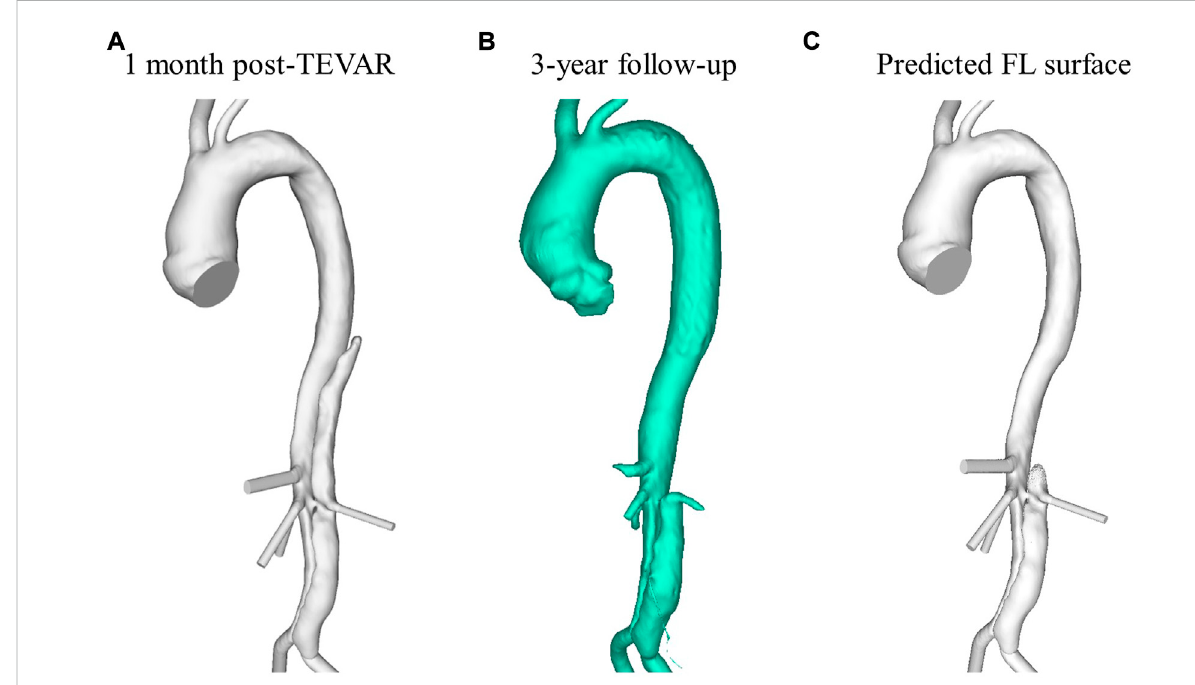
FIGURE 1 Reconstructed aorta from (A) 1-month post-TEVAR and (B) 3-year follow up CT scan. (C) Predicted FL surface after thrombus growth over 20 cardiac cycles using the model presented in this